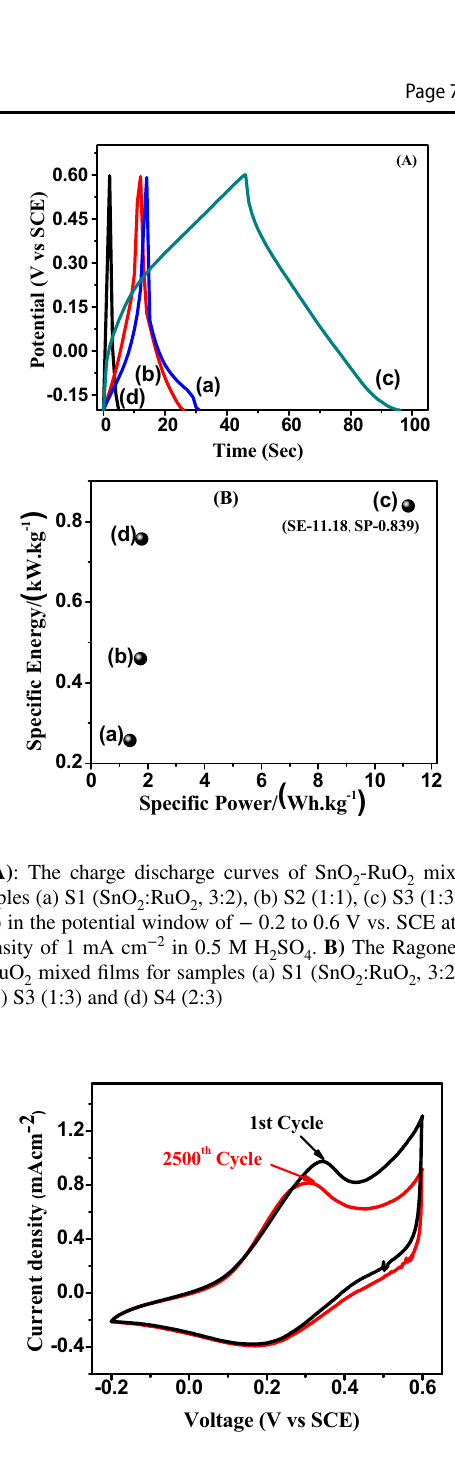
Fig. 7 The stability curve for Sample S3 at 100 mV/s scan rate in the potential window of − 0.2 to 0.6 V vs. SCE at the current density of 1 mA/cm 2 in 0.5 M H 2 SO